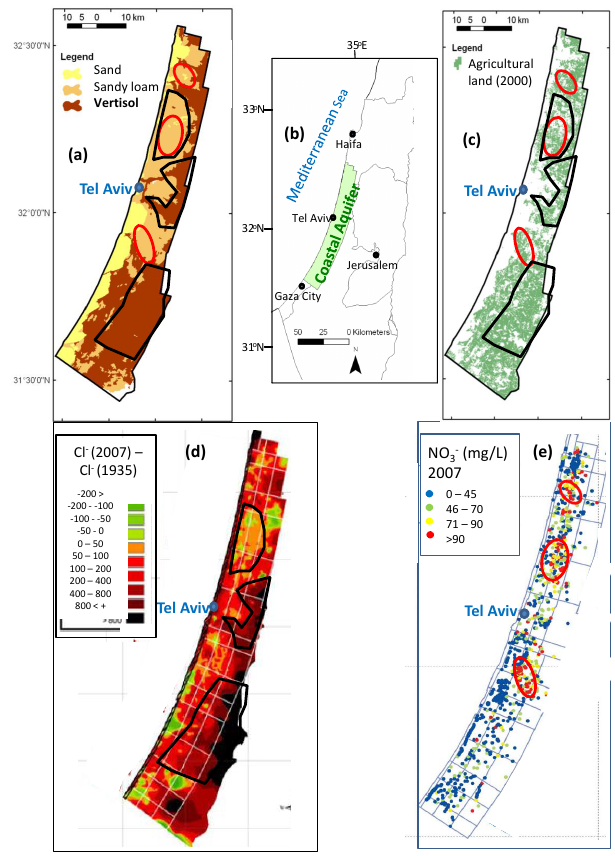
Figure 4. Plan views of the Israeli coastal aquifer. (a) Soil type (black polygons and red ellipses for spatial comparisons with panels d and e, respectively). (b) Location map. (c) Cultivated land in the year 2000. (d) Difference in chloride concentrations between 2007 and 1935 (modified from Livshitz and Zentner, 2009). Black poly- gons are characteristic cultivated areas that were severely salinized (southern polygons) and barely salinized (northern polygon) rela- tive to soil type (panel a ). (e) Nitrate concentration in groundwater wells in 2007 (modified from Hydrological Service, 2008). Red el- lipses – areas with many wells contaminated with nitrate relative to soil type (panel a ; modified from Kurtzman et al.,